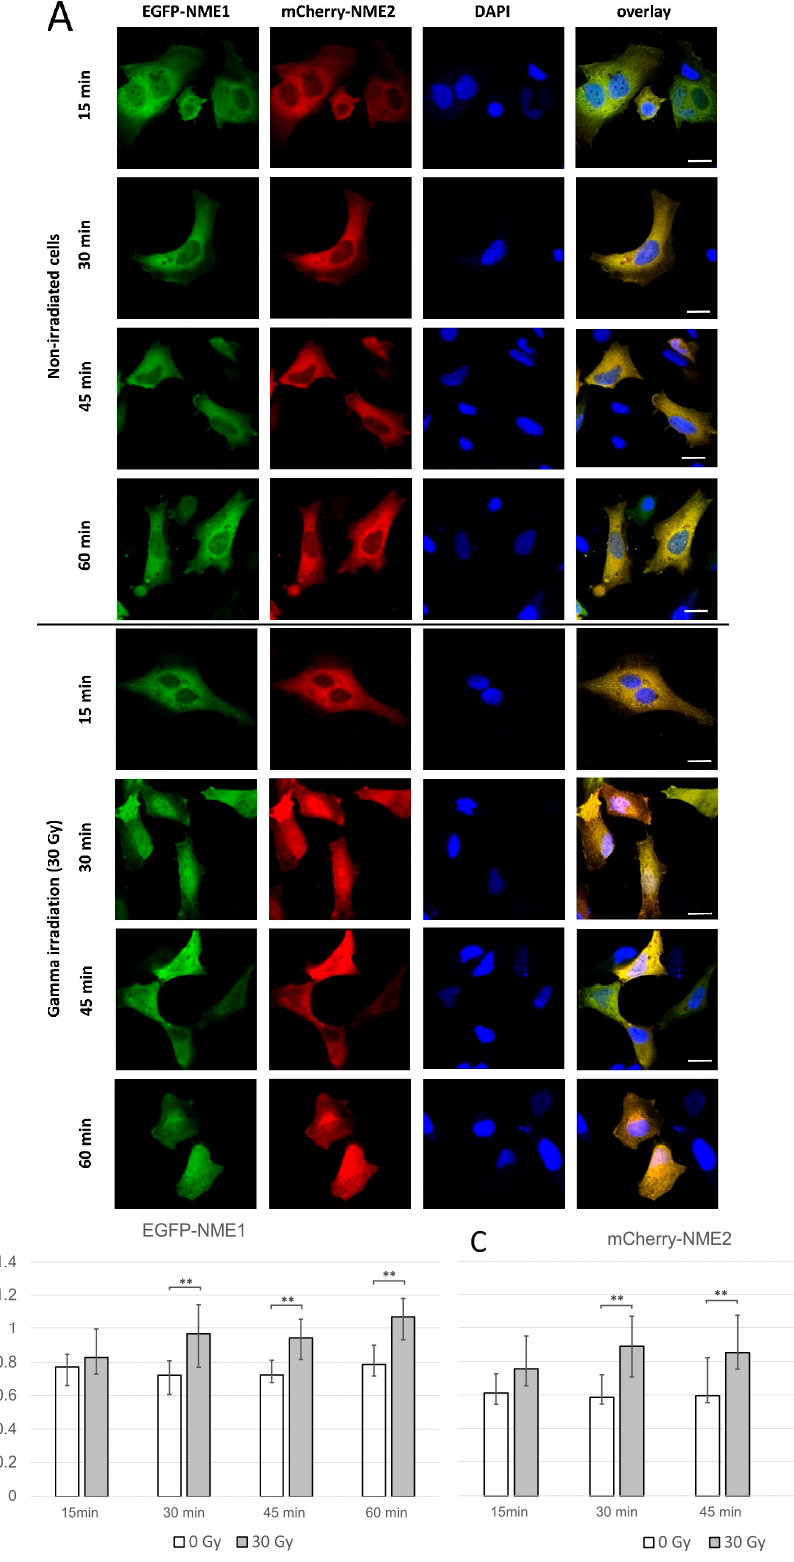
Figure 2. Localization of EGFP-NME1 and mCherry-NME2 in HeLa cells 24 h post-transfection in non-irradiated cells and cells exposed to gamma irradiation (Co-60) of 30 Gy. ( A ) Then, 24 h after transfection, cells were either irradiated or not and then fixed, after an additional period of 15, 30,